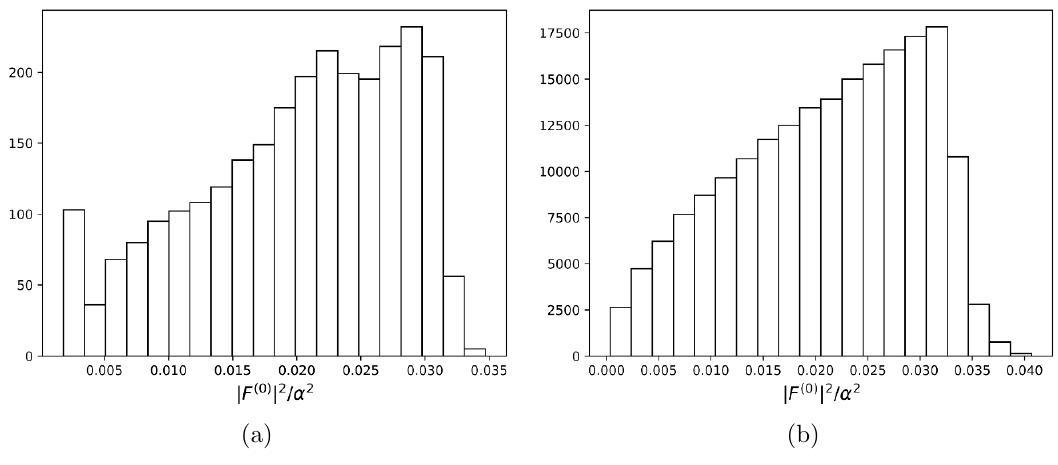
Figure 3. Histograms of j F (0) j 2 =(cid:11) 2 for (a) c 1 = (cid:0) 1 and (b) c 1 = (cid:0) 10. The data are from the same numerical scans as in (cid:12)gures 1 and 2. Plots (a) and (b) each represent a total of 2,701 and 198,903 points